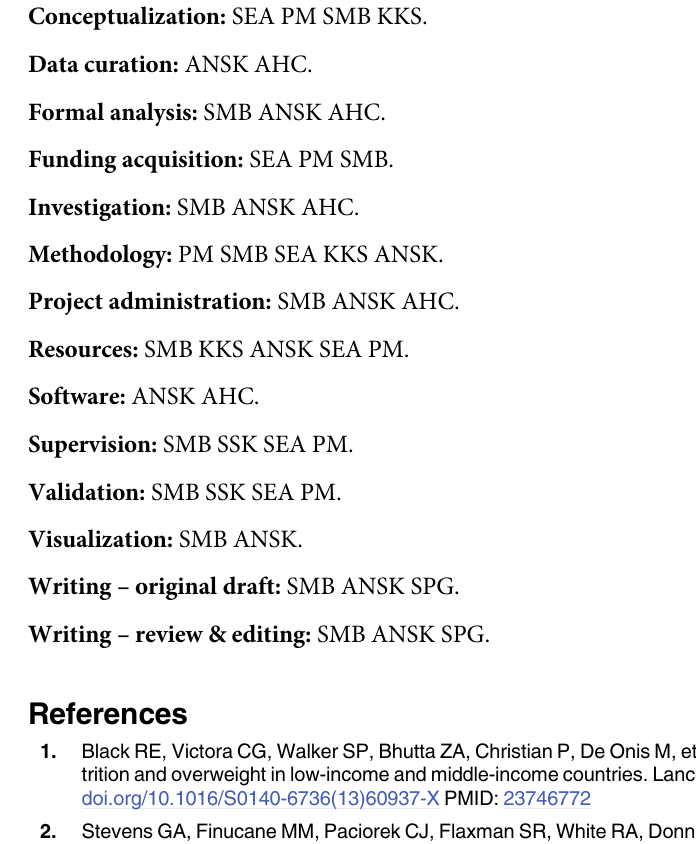
S1 Table. Median consultation time and interquartile range (IQR) of ANC and sick under 5 children within the sub-categories of provider types and their training status. S2 Table. Mothers’/Caregivers’ level of satisfaction with the nutrition service received for their sick under-five